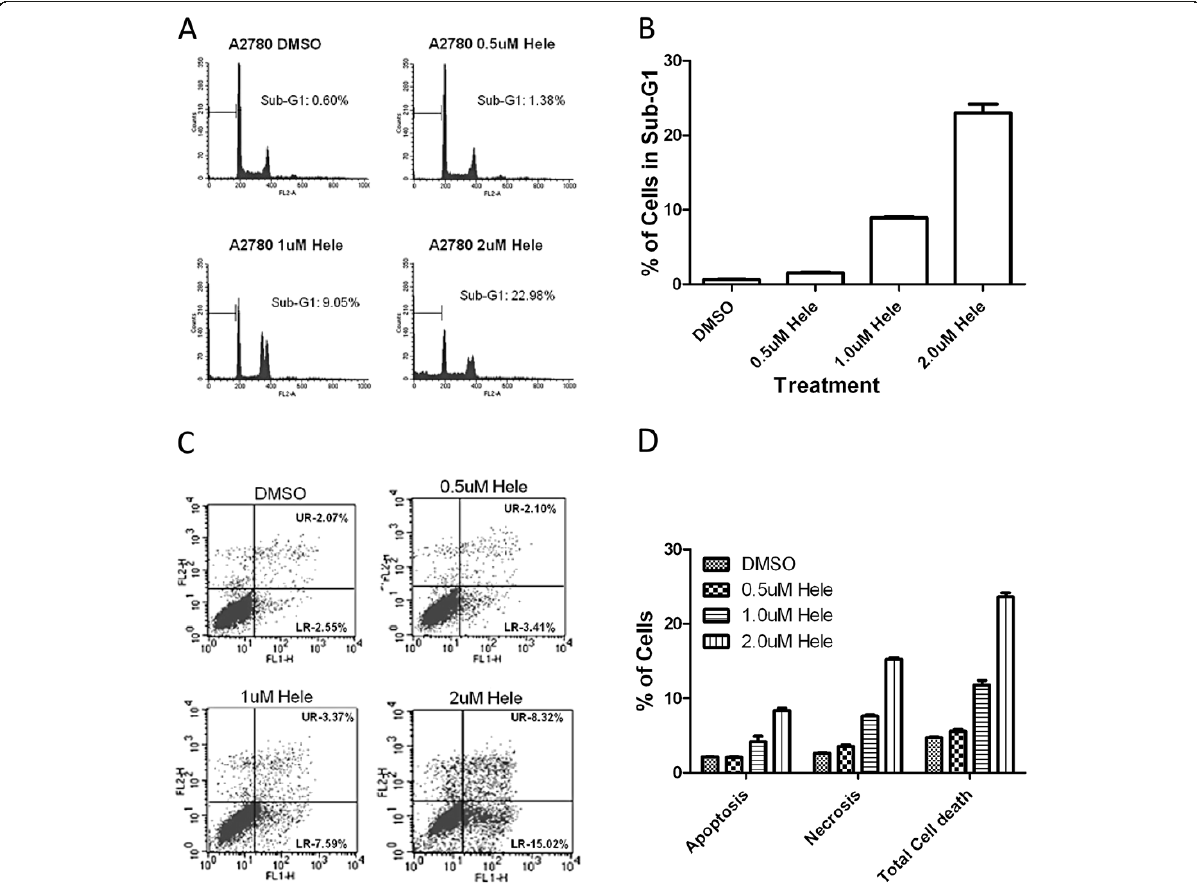
Figure 2 Helenalin induces cell cycle arrest in G1 phase and modulates apoptosis in a dose-dependent manner. ( A ) 1.85×105 cells/ml were seeded onto 6-well plates and incubated for 24 h. Various concentrations of helenalin were added to the culture medium and incubated for an additional 24 h. Cells were then harvested and analyzed by flow cytometry. The cell cycle phase distribution was determined using CellQuest software. ( B ) Percent of cells in Sub-G1 after drug treatment representing three independent experiments. ( C ) Measurement of apoptotic cell death by staining with FITC-Annexin V and Propidium Iodide. Lower right hand quadrant for each dose treatment represents percent of apoptosis, while upper right hand quadrant represents early necrotic cells. ( D ) Percent of cells that are either apoptotic, necrotic or total cell death as measured by staining cells with FITC-Annexin V and Propidium Iodide. Percentages are the average of three independent biological